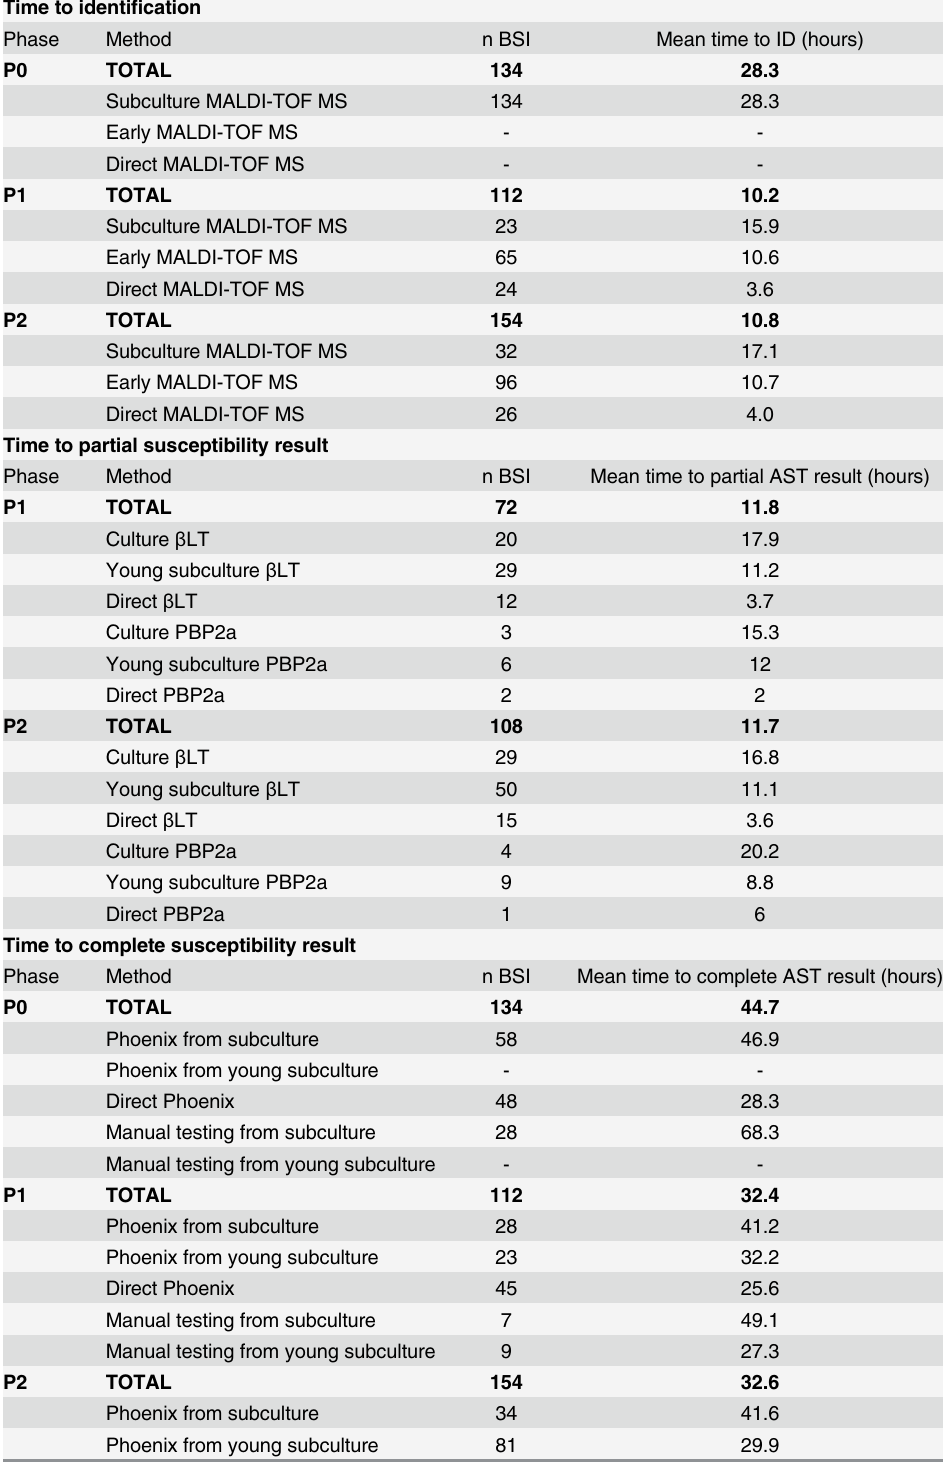
Table 2. Time to identification and time to partial/complete susceptibility results of all bloodstream infections during pre-intervention and intervention period 1 and